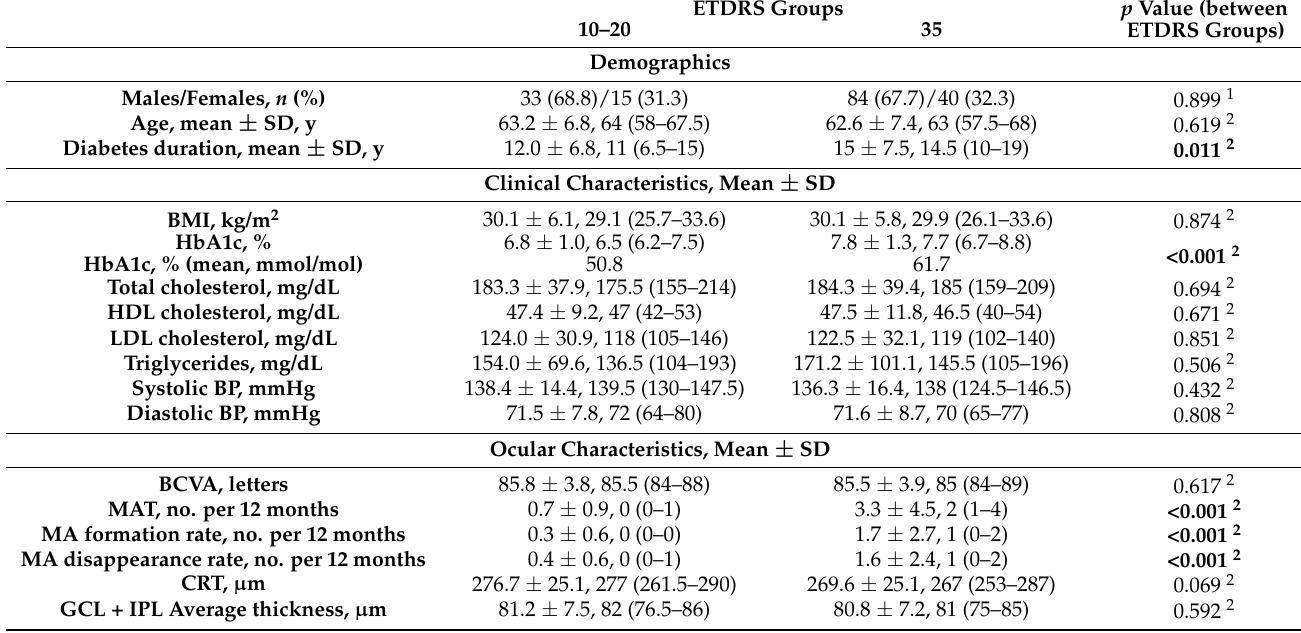
ETDRS Groups p Value (between